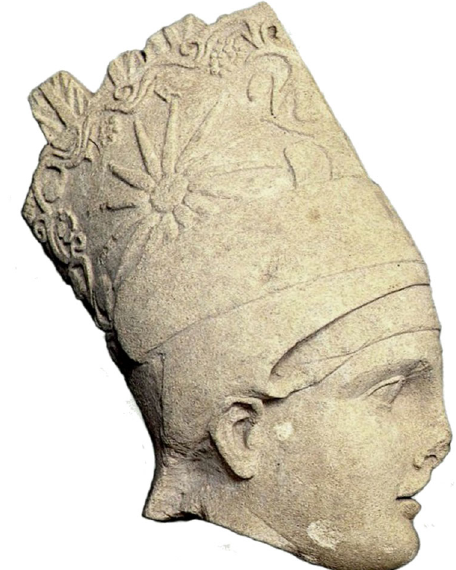
Fig. 3 King Antiochus I. Head of king Antiochus with Regulus on tiara.